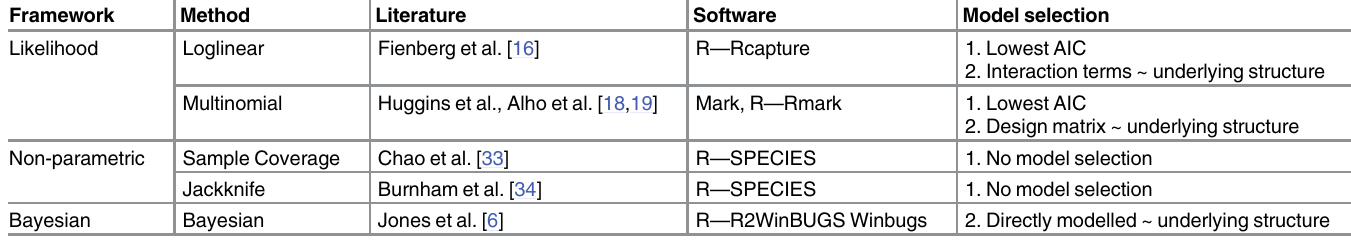
Table 1. Overview of the different estimators, their framework, reference to the literature, the software used and model selection by two approaches (1. Goodness of fit, 2. Assumptions on underlying dependency structure).